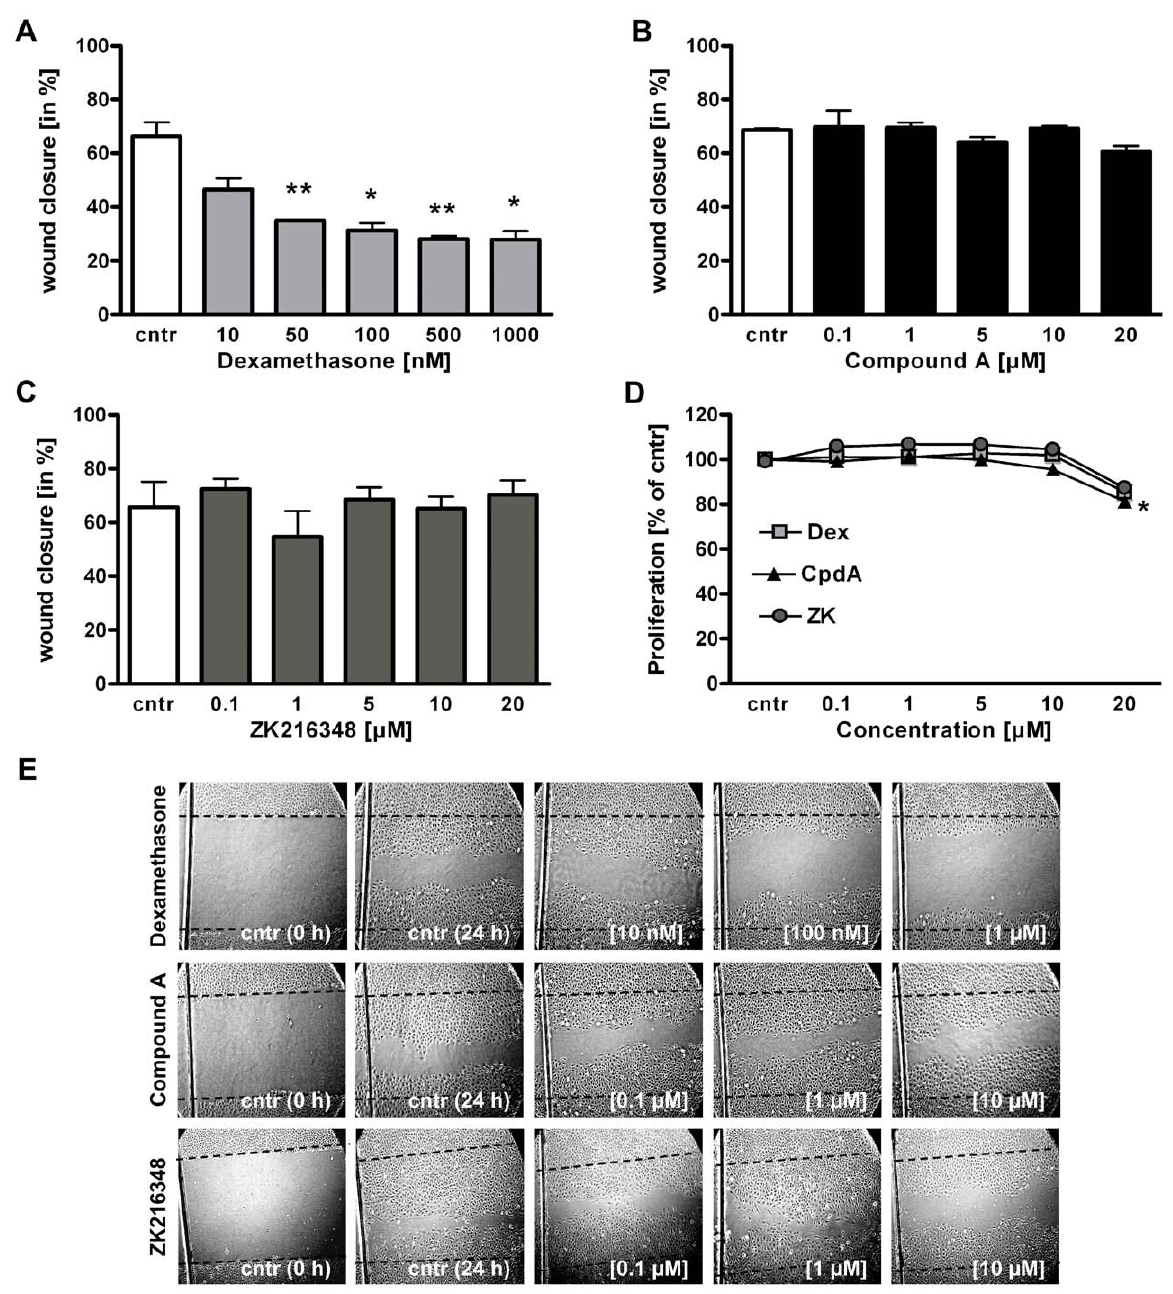
Figure 4. Effect of SEGRAs on intestinal epithelial cell restitution and proliferation. IEC-6 cells were wounded and cultured in the presence of ( A ) Dex [0.1–1 m M] or ( B ) CpdA or ( C ) ZK216348 [1–20 m M] for 24 h. Cell migration was assessed using an in vitro migration assay. Bars indicate mean values of remaining wounded area 6 S.E.M., n=3, * P # 0.05, ** P # 0.01 relative to control. ( D ) BrdU incorporation assay was used for determination of IEC-6 cell proliferation after 24 h incubation with Dex or SEGRAs [1–20 m M]. Results indicate mean 6 S.E.M., n=3, *** P # 0.001 relative to vehicle. ( E ) Representative experiments illustrating the effects of Dex and SEGRAs on intestinal epithelial cell restitution. Cntr (0 h) represents cells immediately after wounding, picture cntr (24 h) and others show wounds 24 h after cultivation with Dex, CpdA or ZK216348. Dotted line indicates original margin of wound (Magnification 6 100). doi:10.1371/journal.pone.0029756.g004 phosphorylation status of Caco-2/GR cells after treatment with Dex or SEGRA indeed revealed reduced ERK1/2 phosphoryla- tion when cells were exposed to Dex, but not CpdA or ZK216348 (Figure 6C). It has been shown that this ERK1/2 phosphorylation (Figure 6D). The same was true for expression of Annexin-1 is blocked by MKP-1, whose expression is typically initiated by the mRNA and protein (Figure 6D and E), likewise a well-known trans-activation mechanism of GCs [35,36]. In comparison to trans-activated gene and competitor for the phosphorylation of